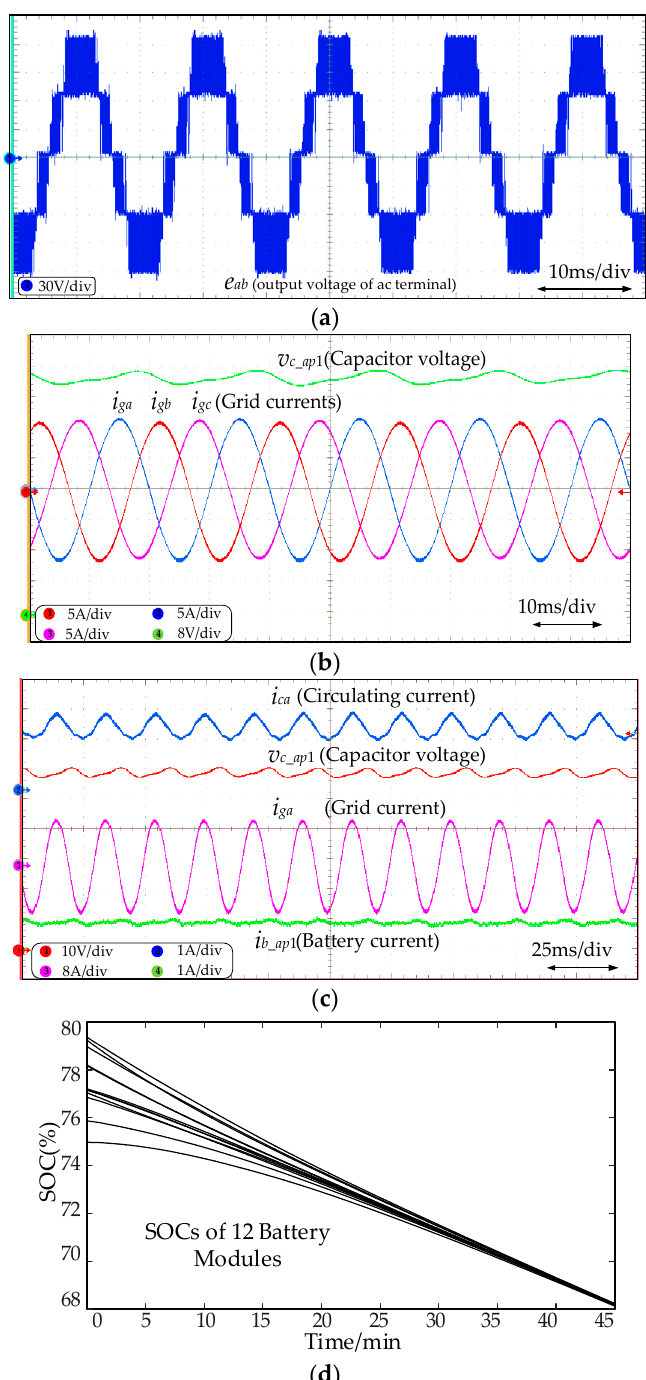
Figure 17. Experimental waveforms of steady-state operation of the MMC-BESS. ( a ) Modulated voltage waveform. ( b ) Grid currents and capacitor voltage. ( c ) Circulating current and battery current. ( d ) SOC equalization process.